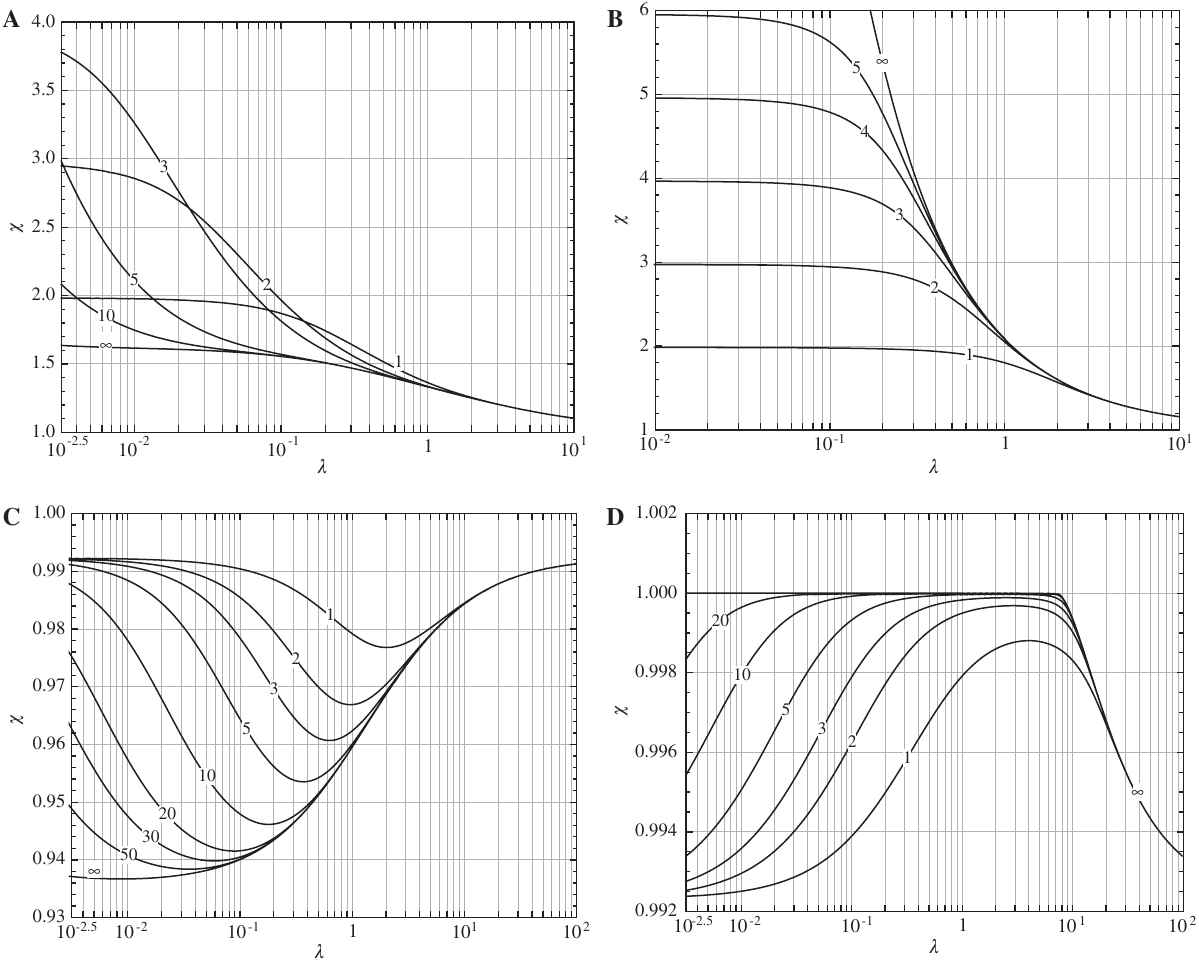
Figure 3: Dispersion curves corresponding to an inhomogeneous MEE layer on homogeneous substrate for various values of dimensionless depth of the layer β h (A) P2 ( n = + 2), (B) P2 ( n = -2), (C) P4 ( n = + 2), (D) P4 ( n =